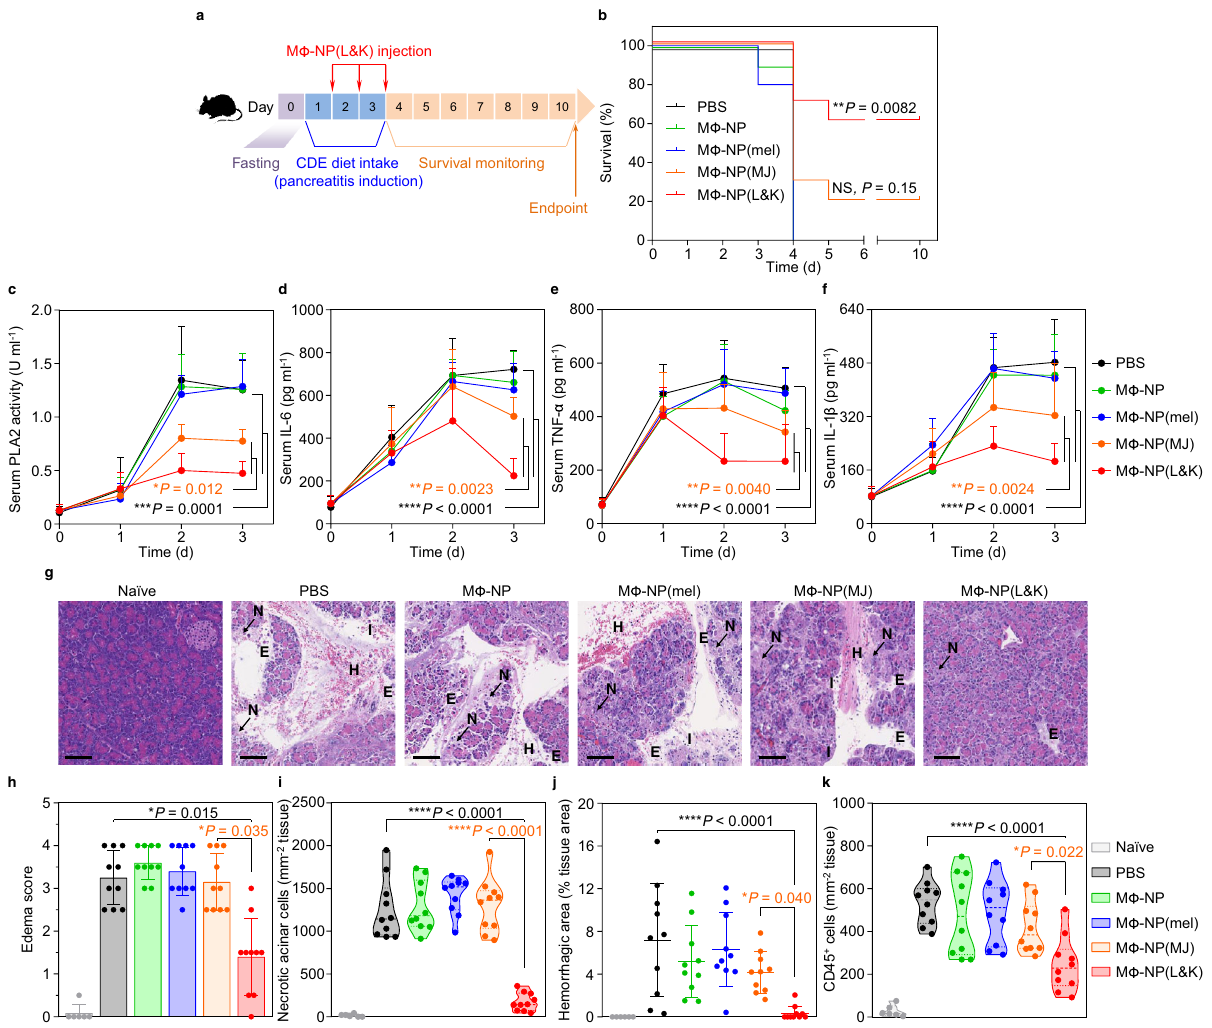
Fig. 5 Therapeutic ef fi cacy in a mouse model of severe acute pancreatitis. a The study protocol of lethal pancreatitis induction and treatment with M Φ - NP(L&K). b Survival rates of mice over 10 days after initial diet intake. NS not signi fi cant. c PLA2 activity pro fi les in serum of CDE-AP mice treated with different formulations. Concentration pro fi les of key in fl ammatory cytokines, including IL-6 ( d ), TNF- α ( e ), and IL-1 β ( f ), of CDE-AP mice treated with different formulations. g Representative images of H&E staining on pancreas sections from CDE-AP mice collected on day 3 after initial diet intake. Scale bars, 100 μ m. N acinar necrosis, E edema, I cell in fi ltration, H hemorrhage. h Edema score of H&E-stained pancreas sections from CDE-AP mice after receiving different nanoparticle treatments. i Quanti fi cation of necrotic cells in the H&E-stained pancreas sections from CDE-AP mice receiving different nanoparticle treatments. j Quanti fi cation of hemorrhagic area in the H&E-stained pancreas sections from of CDE-AP mice receiving different nanoparticle treatments. k Quanti fi cation of CD45 + cells in the anti-CD45-stained pancreas sections from CDE-AP mice treated with different formulations. For survival study, statistical analysis was performed on groups treated with M Ф -MJ-NPs or M Φ -NP(L&K) in comparison with PBS-treated group using a two-tailed log-rank (Mantel – Cox) test. For serum PLA2 and cytokine pro fi les, statistical analysis was performed using repeated-measure one-way ANOVA with Dunnett ’ s post hoc analysis. Statistical difference in edema scores was analyzed by Kruskal – Wallis non-parametric test with Dunnett ’ s post hoc analysis. Necrotic cell counts, quanti fi cation of hemorrhagic area, and CD45 + cell counts were analyzed by using one-way ANOVA with Dunnett ’ s post hoc analysis. Data presented as mean ± s.d. * P ≤ 0.05, ** P ≤ 0.01, *** P ≤ 0.001, **** P ≤ 0.0001. In the study, n = 10 mice in CDE-AP model. All mice were treated